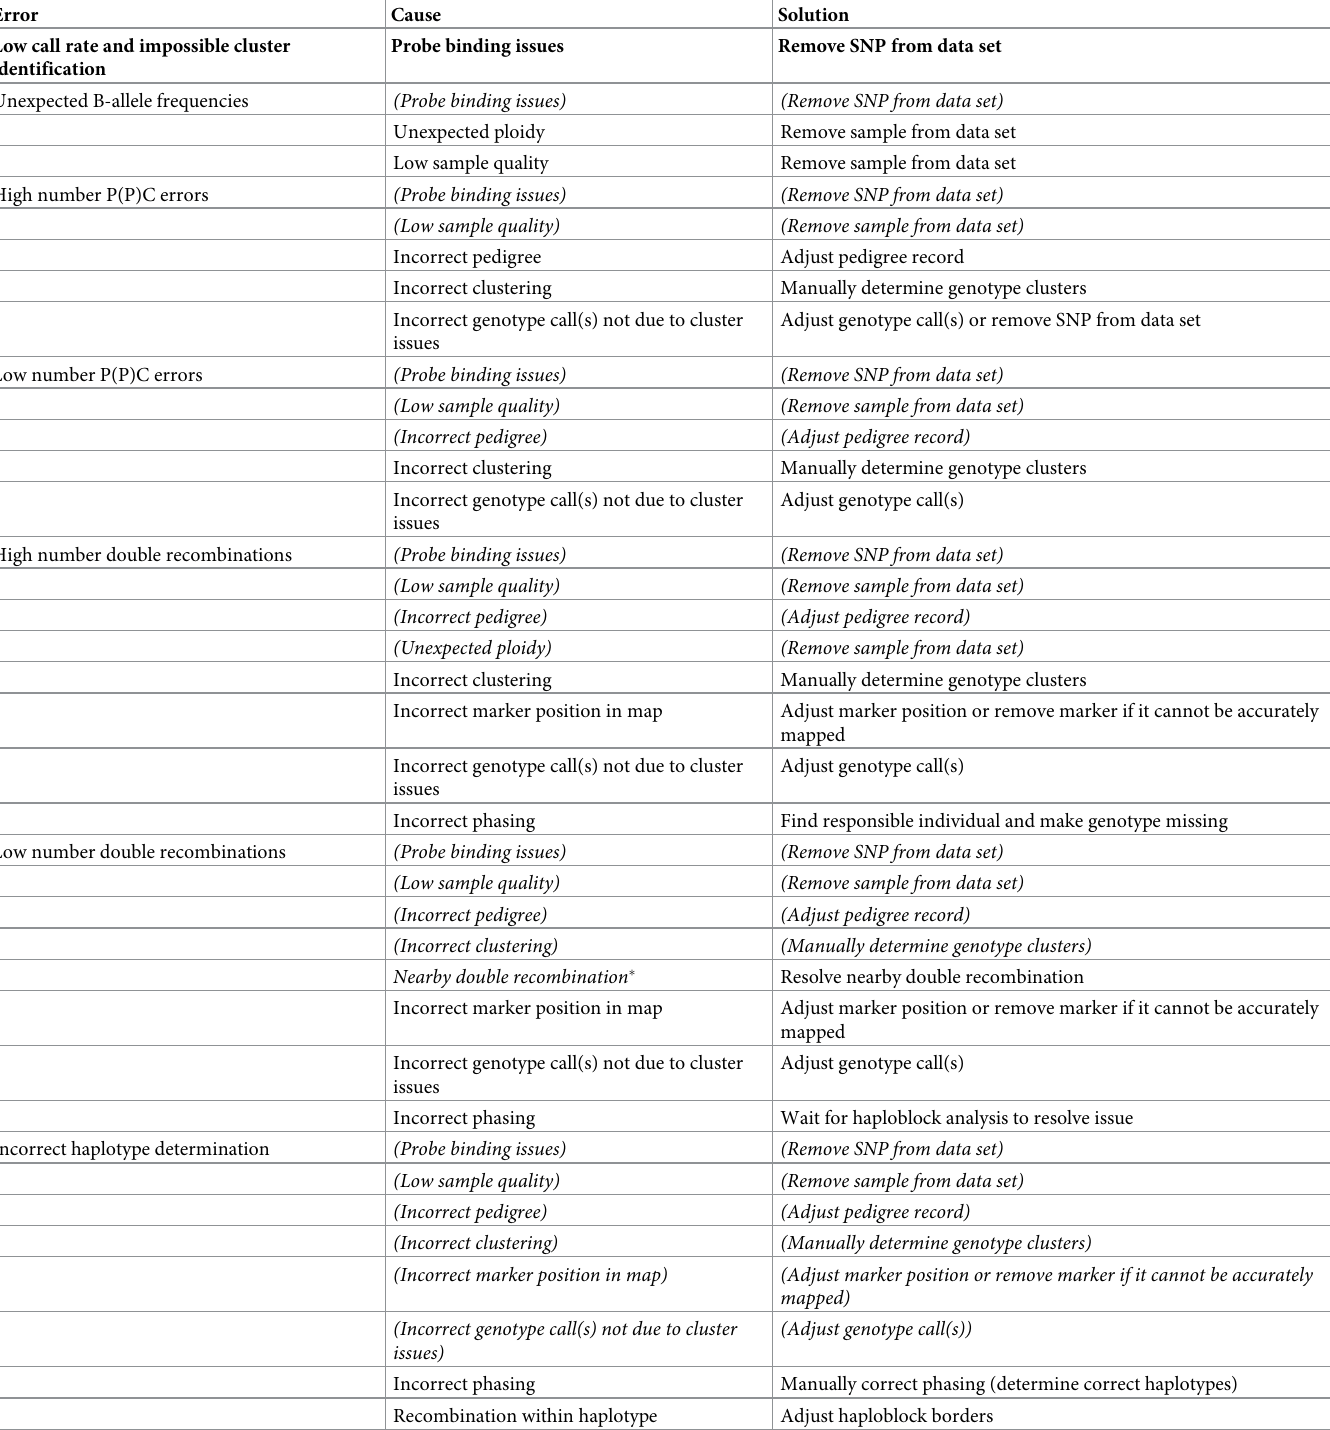
Table 1. Errors observed during the curation process and their possible causes. Causes that should be (mostly) already resolved by the stage a researcher would start checking for specific errors are in parentheses and